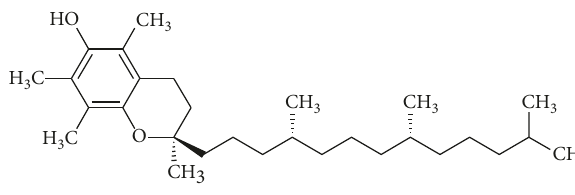
Figure 1: The structure of α